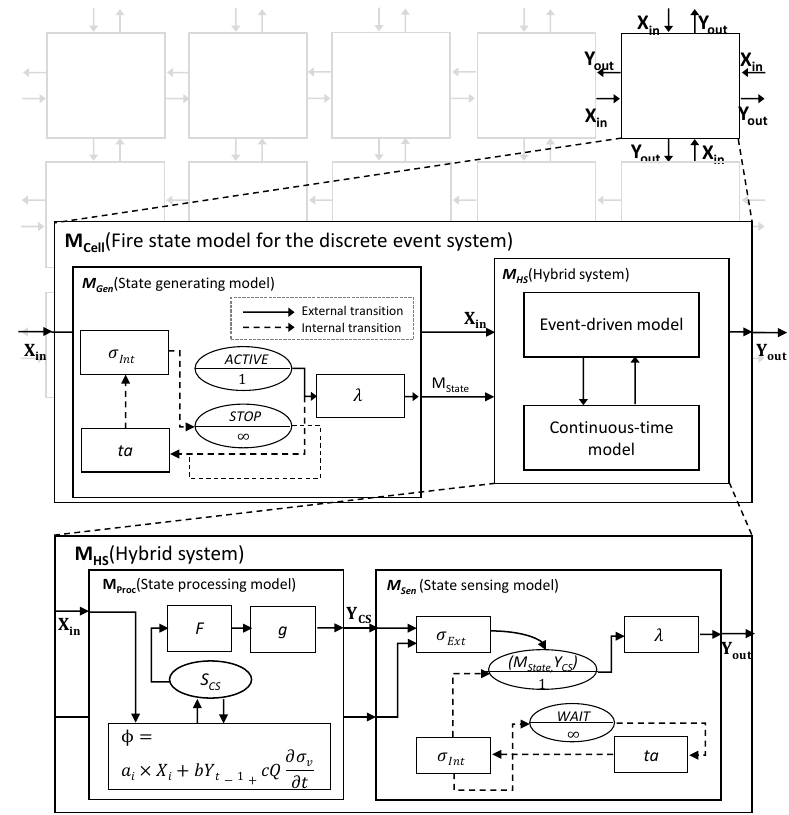
Figure 8. DEVS based fire-spreading model of a large-scale hybrid